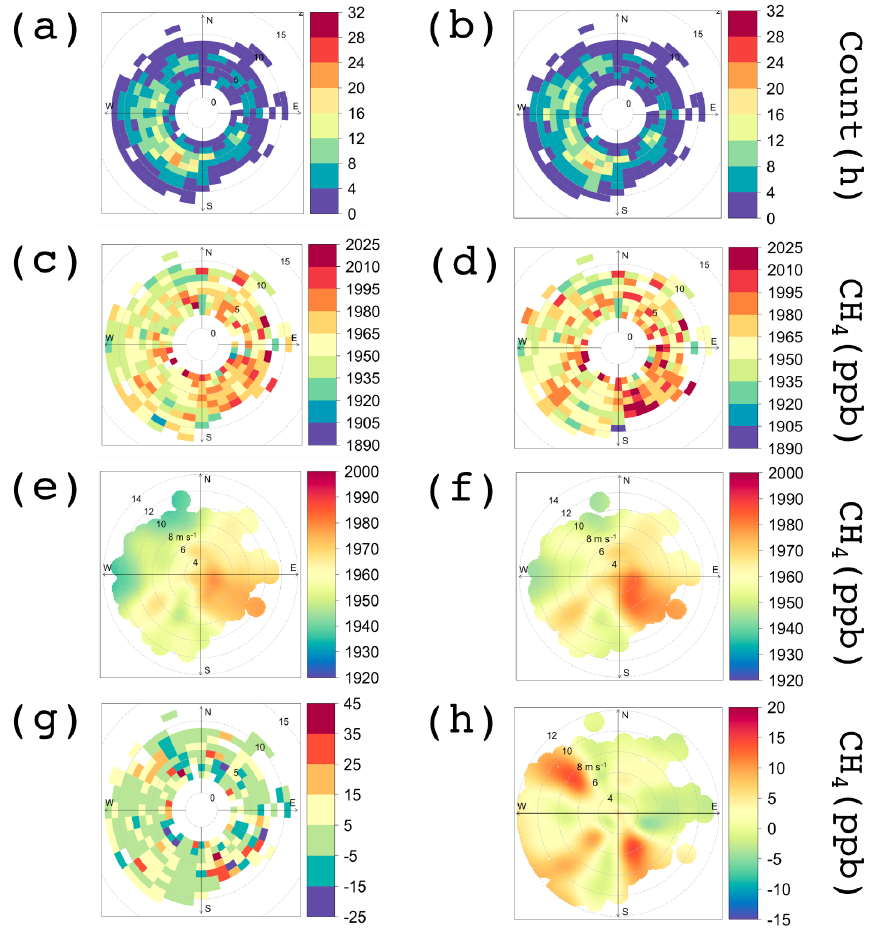
Figure 4. Frequency and bivariate polar plots of CH 4 background for Indianapolis using data from 12:00–16:00LST, November 2014 through December 2016 given two different criteria (Table 1). (a) Polar histogram indicating a number of hourly measurements available using criterion 1. (b) Same as (a) only for criterion 2. Differences between (a) and (b) are due to slight differences in data availability at the considered towers. (c) Polar frequency plot of the CH 4 background using criterion 1. (d) Same as (c) only for criterion 2. (e) Polar bivariate plot of CH 4 background using criterion 1. (f) Same as (e) only for criterion 2. (g) Polar frequency plot of difference between the backgrounds: criterion2 − criterion1. (h) Same as (g) but shown with a bivariate polar